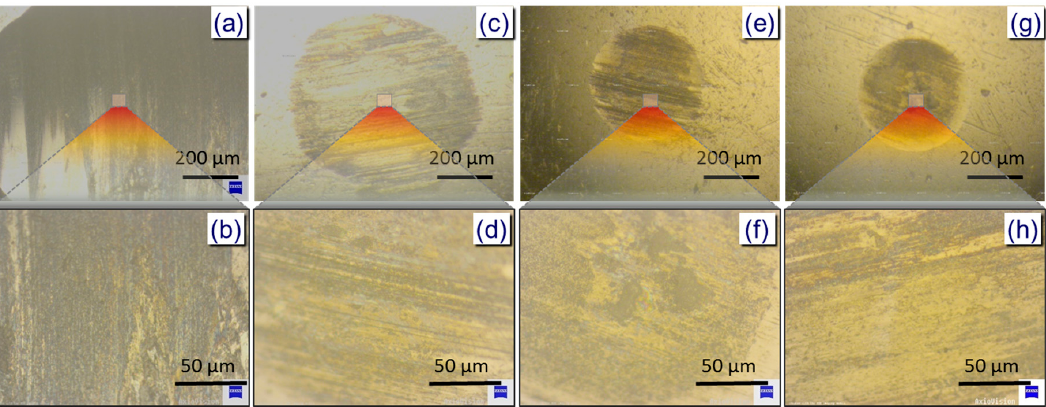
Figure 7. The surface morphologies of the wear scars observed by optical microscopy using different lubricant: ( a , b ) base oil, ( c , d ) 0.005%, ( e , f ) 0.01%, and ( g , h ) 0.05%.